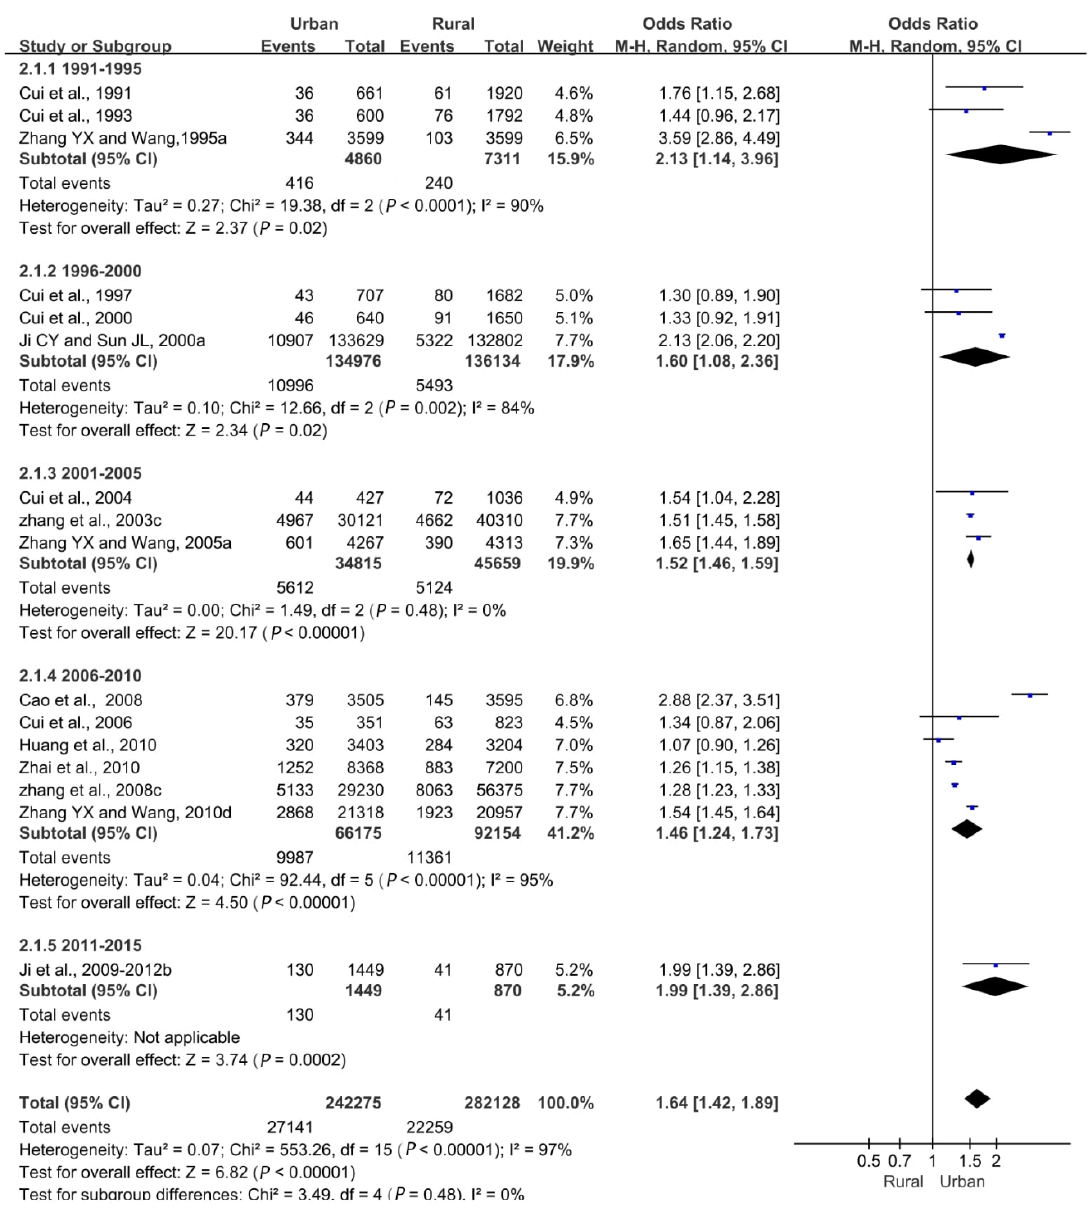
Figure 3. Forest plot of overweight in urban children and adolescents compared with rural children and adolescents aged 0 – 18 years.